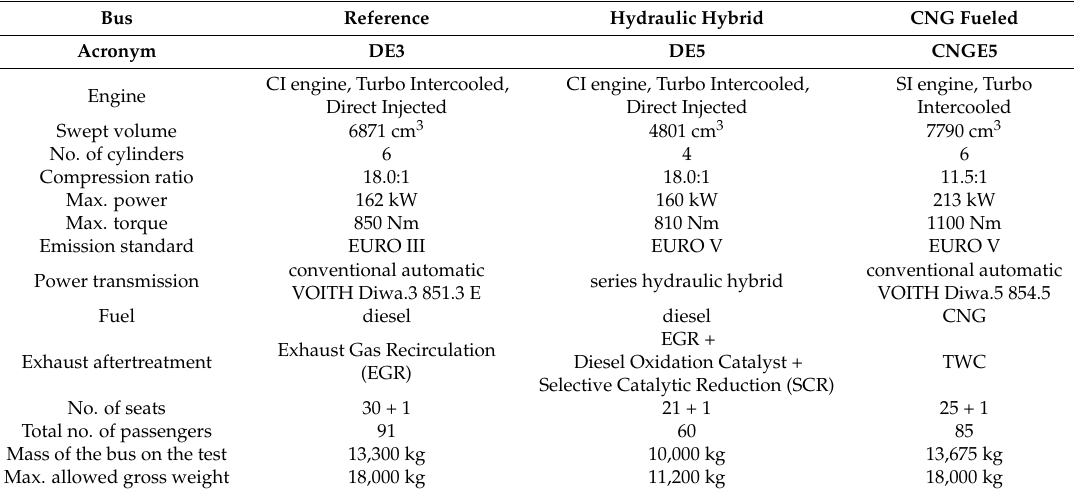
Table 1. Main characteristics of the tested